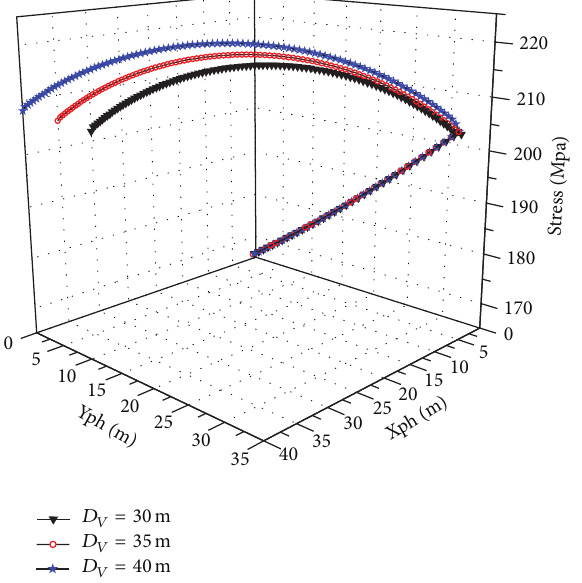
Figure 12: Maximum stresses in different 𝐷 𝑉